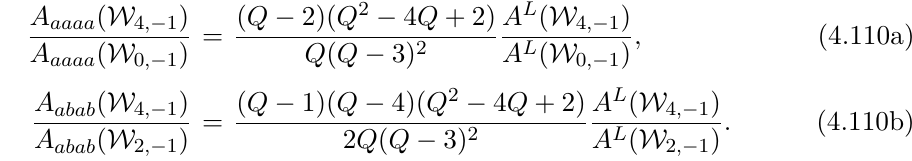
Figure 24 . The amplitude of W 4 , 1 in the combination P aaaa + 2 of (3.1)) which is approximated by the four-point function of [19] (the left-hand side of (3.1)) whose spectrum does not include these fields. The values are generically small and vanishes at Q = 0 , 3 , 4 where the approximation becomes